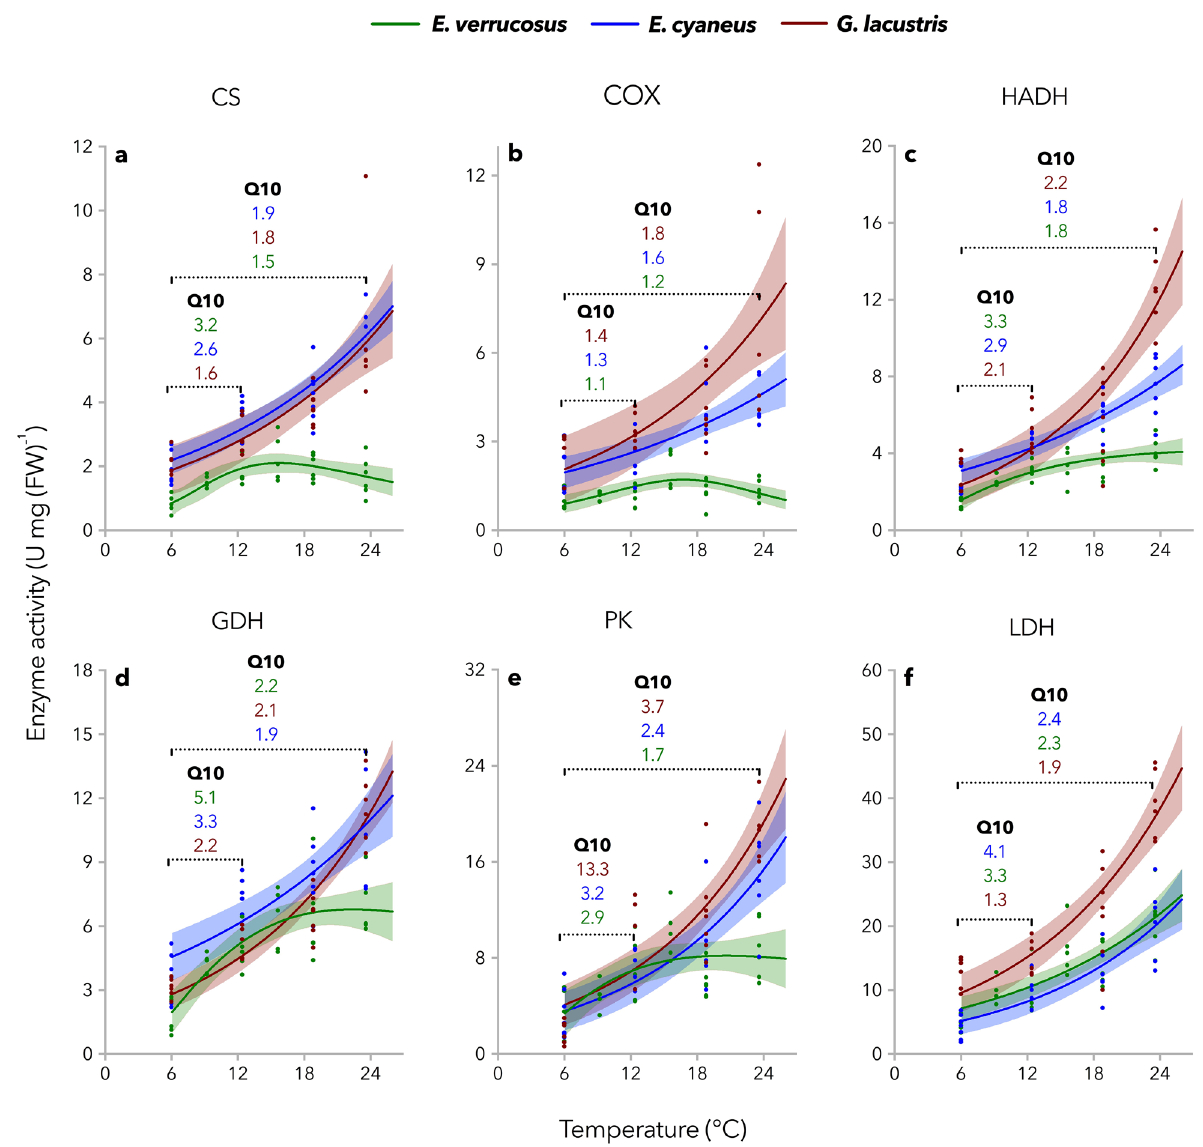
Figure 2. Species-specific thermal reaction norms of maximum enzyme activities. Citrate synthase (CS), cytochrome-c-oxidase (COX), 3-hydroxyacyl-CoA dehydrogenase (HADH), glutamate dehydrogenase (GDH), pyruvate kinase (PK), and lactate dehydrogenase (LDH) were extracted from tissues of E. verrucosus , E. cyaneus and G. lacustris exposed to gradual temperature increase (0.8 °C d −1 ). Samples of all three species were taken at 6 °C, 12.4 °C, 18.8 °C, and 23.6 °C; besides, samples of E. verrucosus were taken at 9.2 °C and 15.6 °C. Measurements were performed at the respective sampling temperatures. Enzyme activities level off at temperatures exceeding about 15 °C in the stenothermal Lake Baikal endemic amphipod species E. verrucosus (except for LDH). At the same time, they increase exponentially over the entire thermal range in the two more eurythermal species E. cyaneus (Lake Baikal, endemic) and G. lacustris (Holarctic, ubiquitous). Dots represent raw data. Solid lines represent nonlinear models (equations are summarized in Table S2; Supplement), and shaded areas display 95% confidence intervals (n =